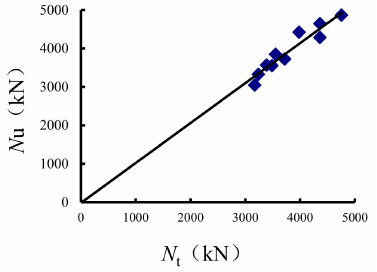
Figure 3. Ultimate bearing capacity simulation and comparison with the